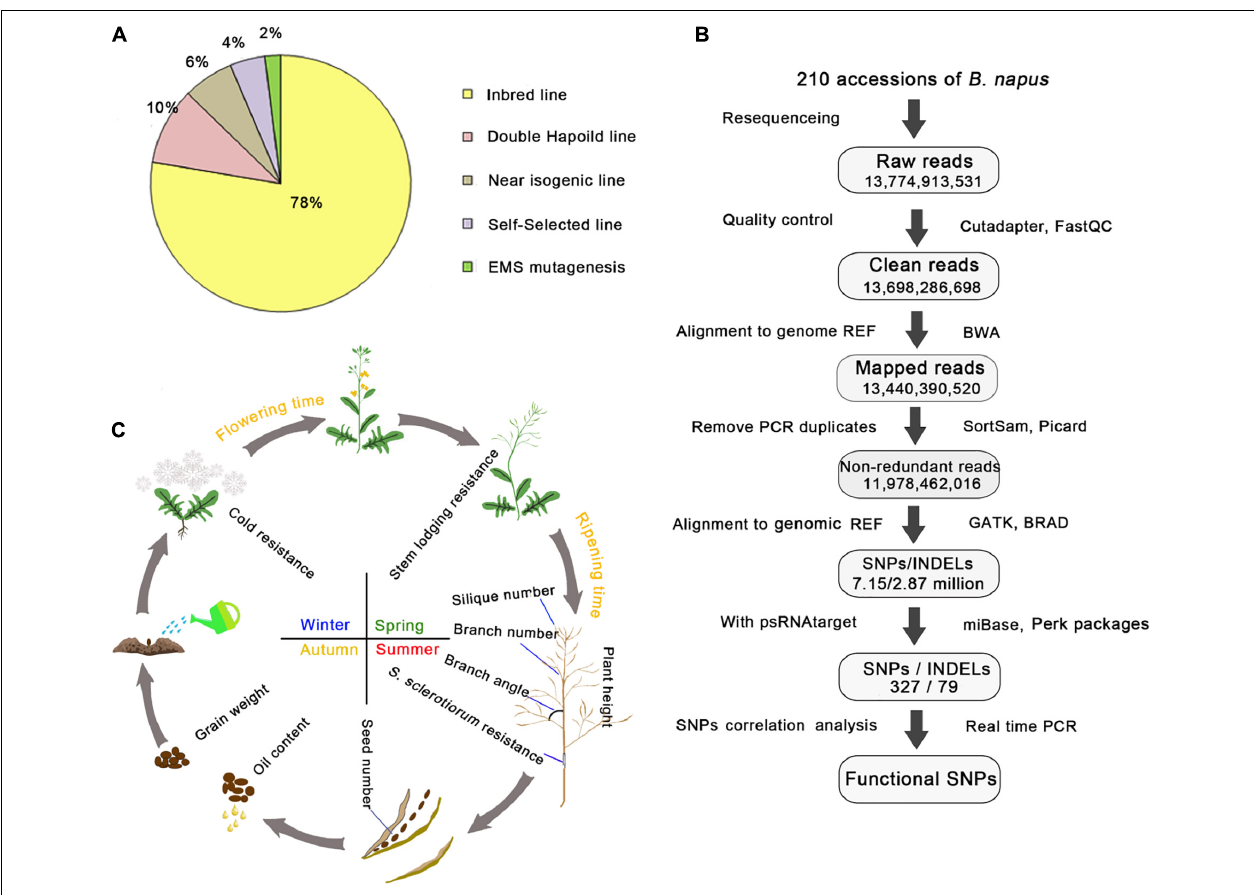
FIGURE 1 | Summary of the 210 rapeseed accessions exhibiting 12 important agronomic traits and the pipeline for analyzing genetic variations. (A) Percentages of different rapeseed categories. (B) Pipeline for the DNA re-sequencing and correlation analysis. Genome REF refers to the B. napus “Darmor” reference genome, whereas transcript REF refers to the B. napus transcript reference sequences; both were downloaded from the BRAD website. The number in each frame represents the sum of the values. Cutadapter, FastQC, BWA, SortSam, Picard, GATK, and psRNATarget were the main bioinformatic tools used in the pipeline, whereas TAIR, BRAD, and miRBase were the key databases used in this study. (C) Schematic representation of the 12 important agronomic traits. The arrows indicate a life